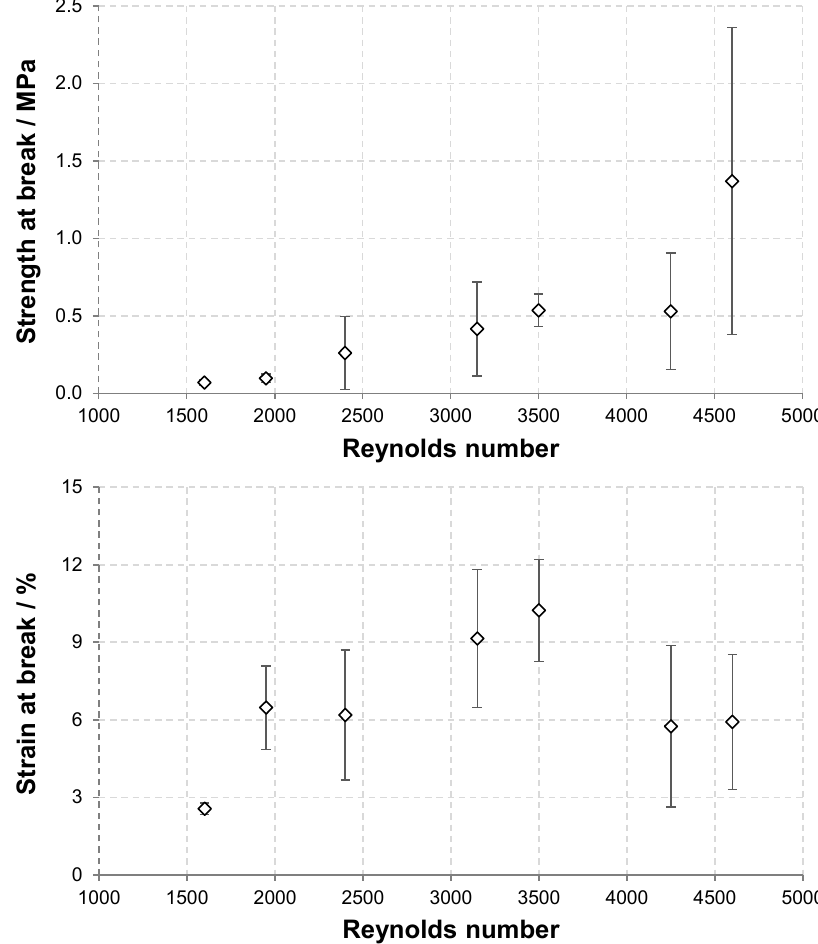
Figure 5. Dependence of the strength and strain at break of HA nonwoven textiles on Re.